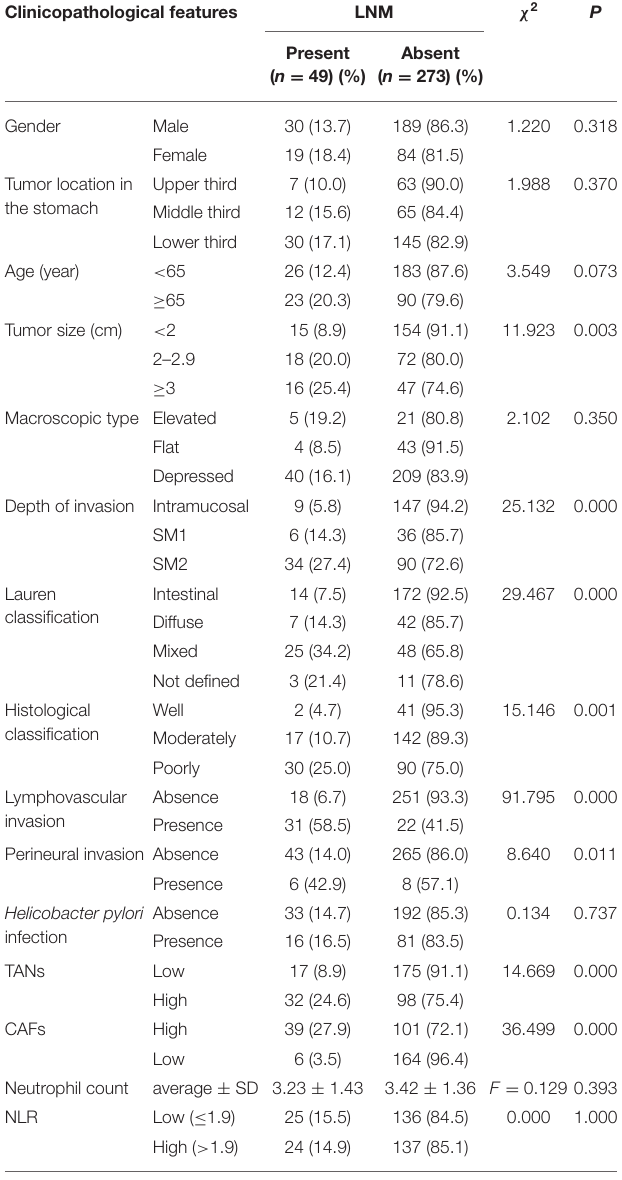
TABLE 2 | Clinicopathological features associated with LNM in EGC patients. Clinicopathological features